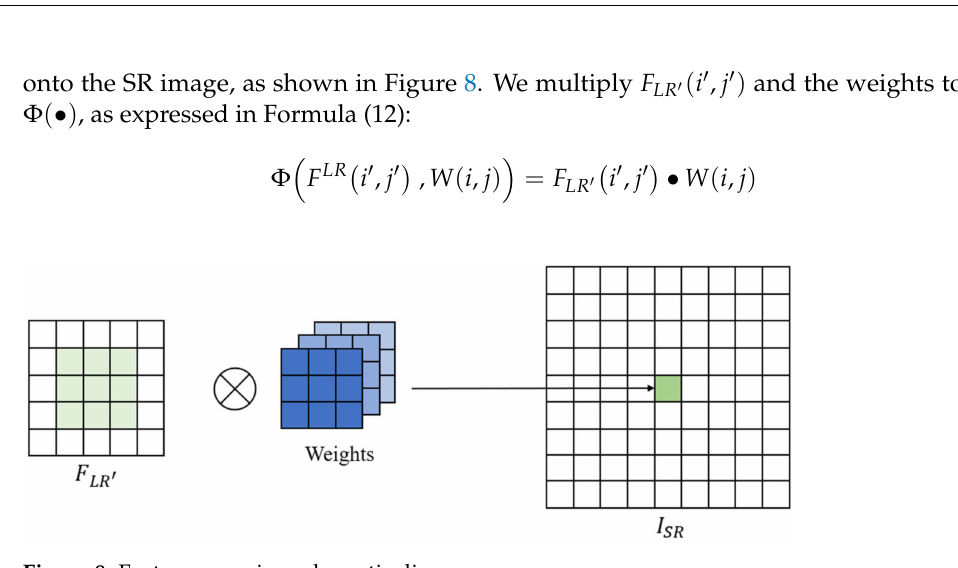
Figure 8. Feature mapping schematic